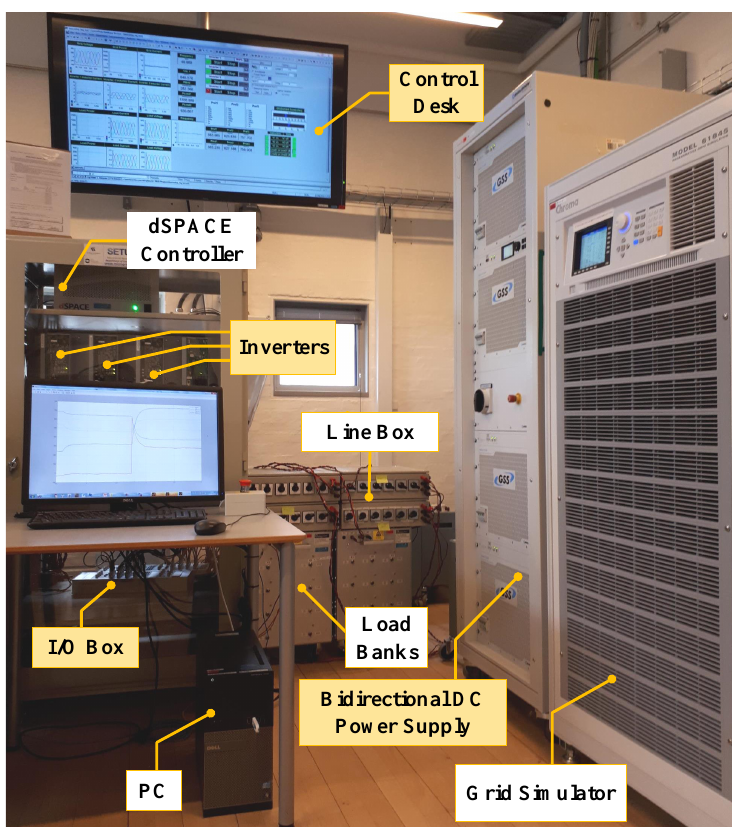
Figure 8. Experimental setup.